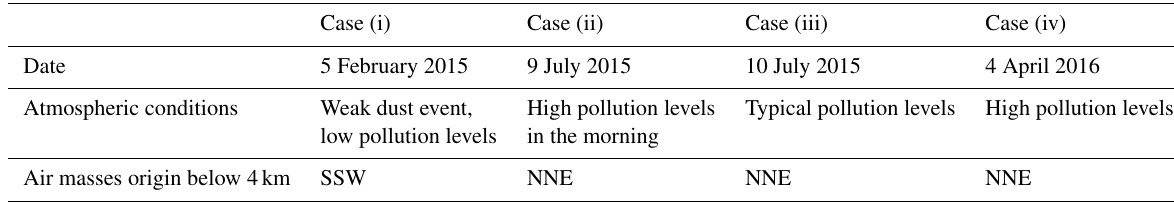
Figure 2. Analytical back trajectories for Athens as derived from the NOAA HYSPLIT model for the case studies (i) 5 February 2015 (a) , (ii) 9 July 2015 (b) , (iii) 10 July 2015 (c) and (iv) 4 April 2016 (d) . Table 2. Information about the selected case